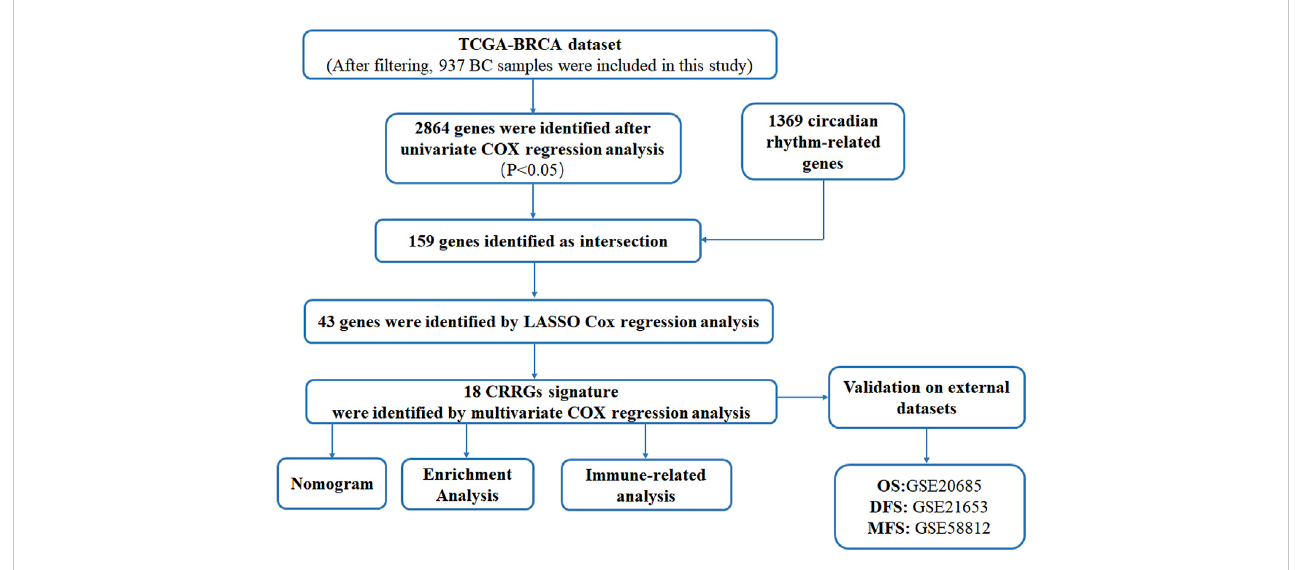
FIGURE 1 Flow diagram of this